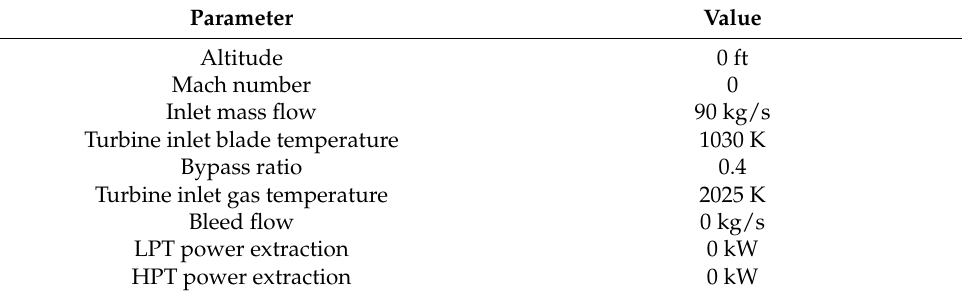
Table 4. Common characteristics of the design points.